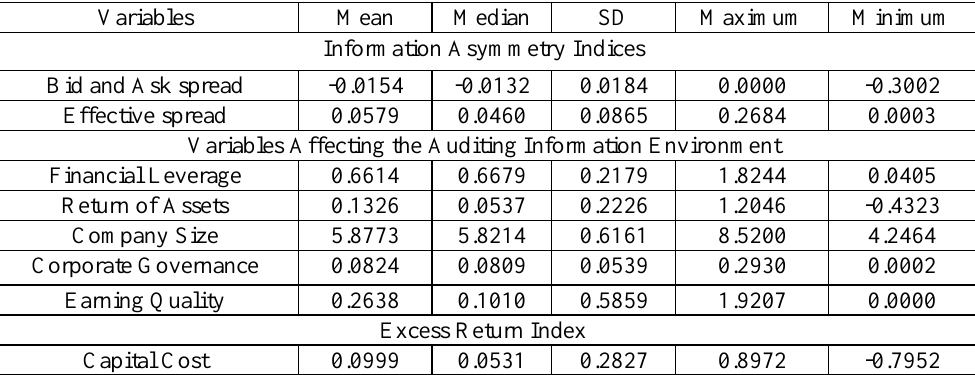
Table 2. Descriptive statistics of research